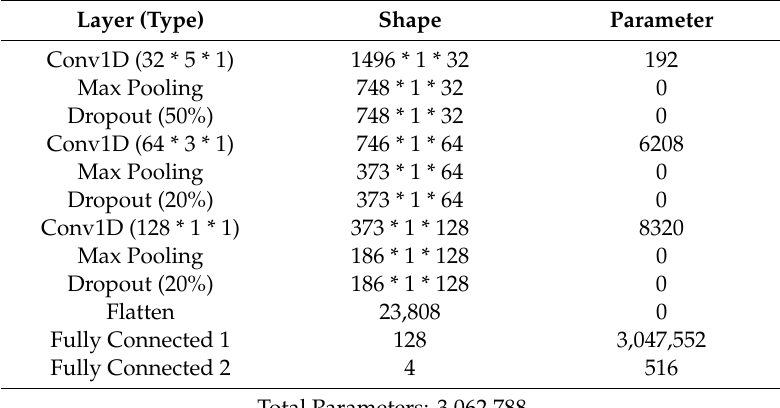
Figure 5. Detail map of convolution neural network (CNN) architecture for time series vibration classification. Table 1. Detail overview of CNN model architecture used in the